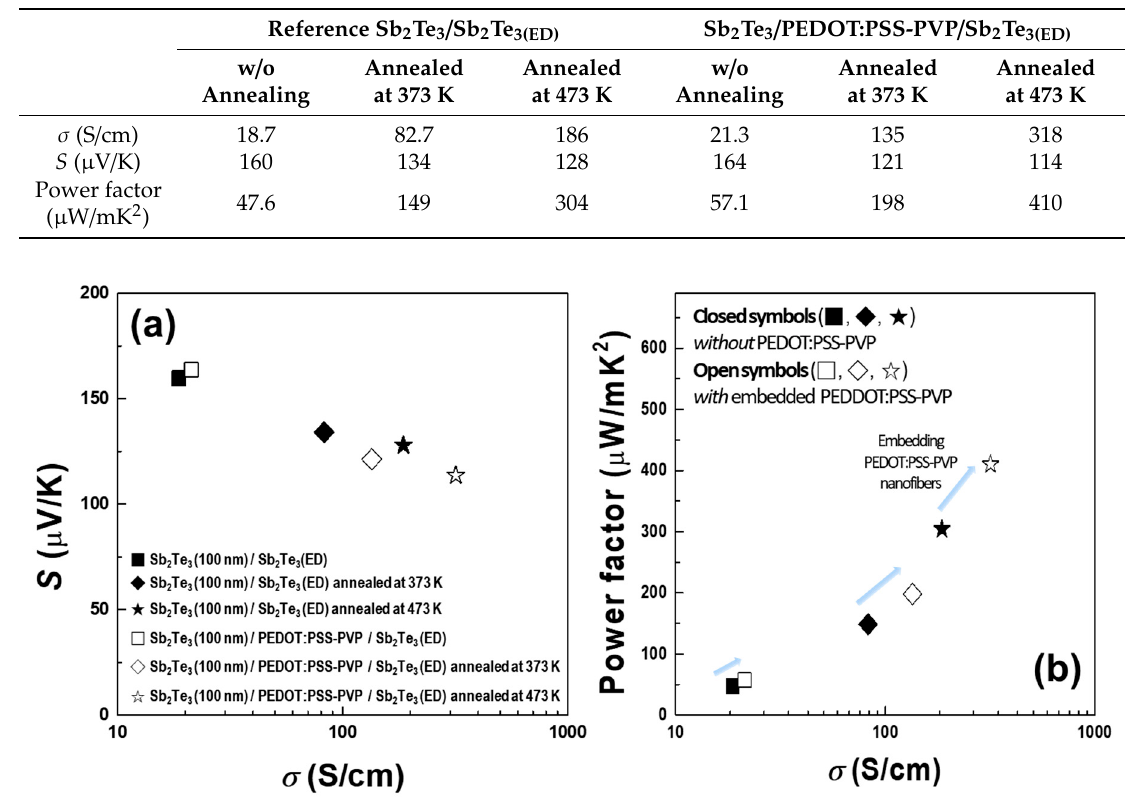
Table 1. σ , S , and power factor values of reference Sb 2 Te 3 /Sb 2 Te 3(ED) film and the Sb 2 Te 3 /PEDOT:PSS- PVP/Sb 2 Te 3(ED ) films with different annealing conditions. Sb 2 Te 3 / PEDOT:PSS-PVP / Sb 2 Te 3(ED) films with di ff erent annealing conditions.